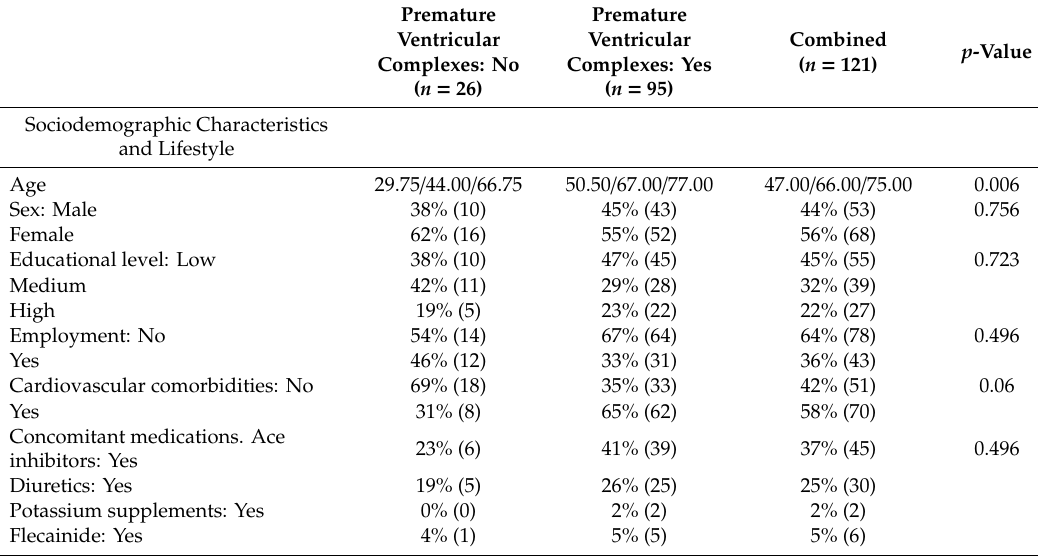
Table 1. Descriptive statistics according to presence / absence of PVCs. Data are percentages (absolute numbers) for categorical variables, and Quartile I / median / Quartile III for continuous